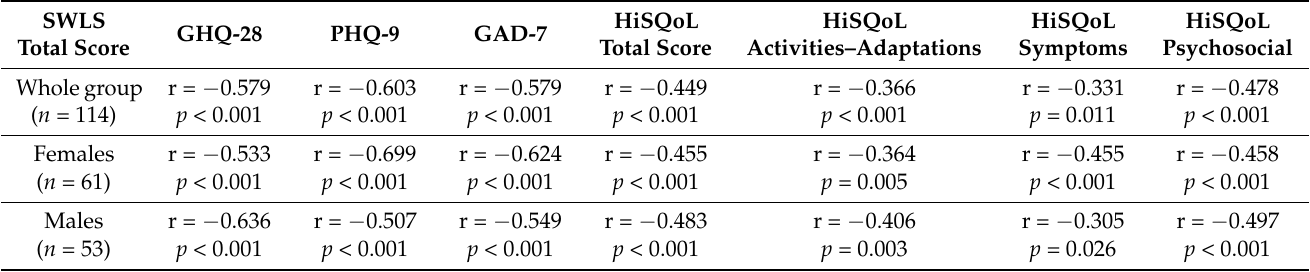
Table 3. Correlations of satisfaction with life with different psychosocial